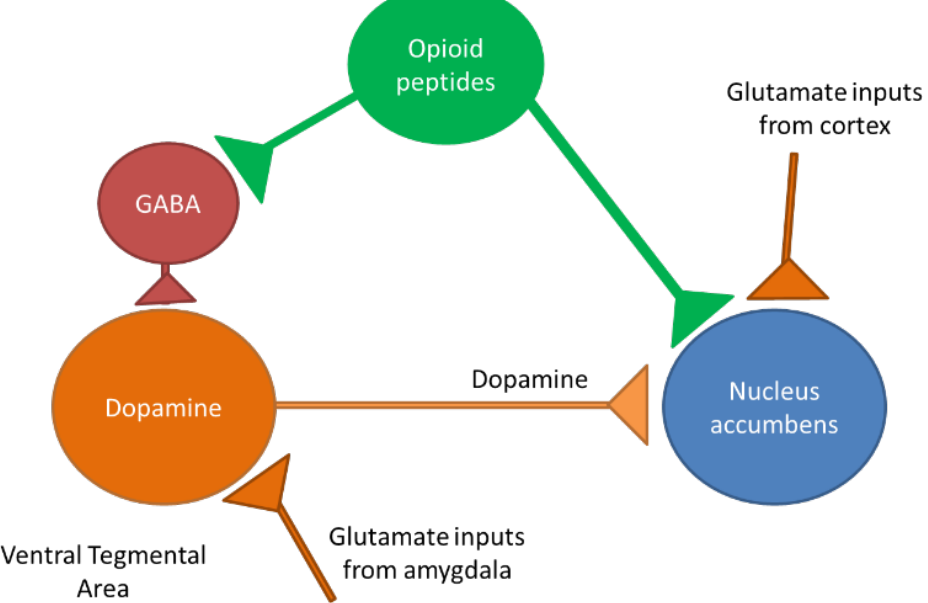
Figure 1. Schematic representation of the reward pathway. The figure shows the interplay between different neurons where the nucleus accumbens seems to be the central player, receiving the projection of dopaminergic, glutamatergic and opioidergic neurons. The model for food addiction might be quite different and is under examination [74].